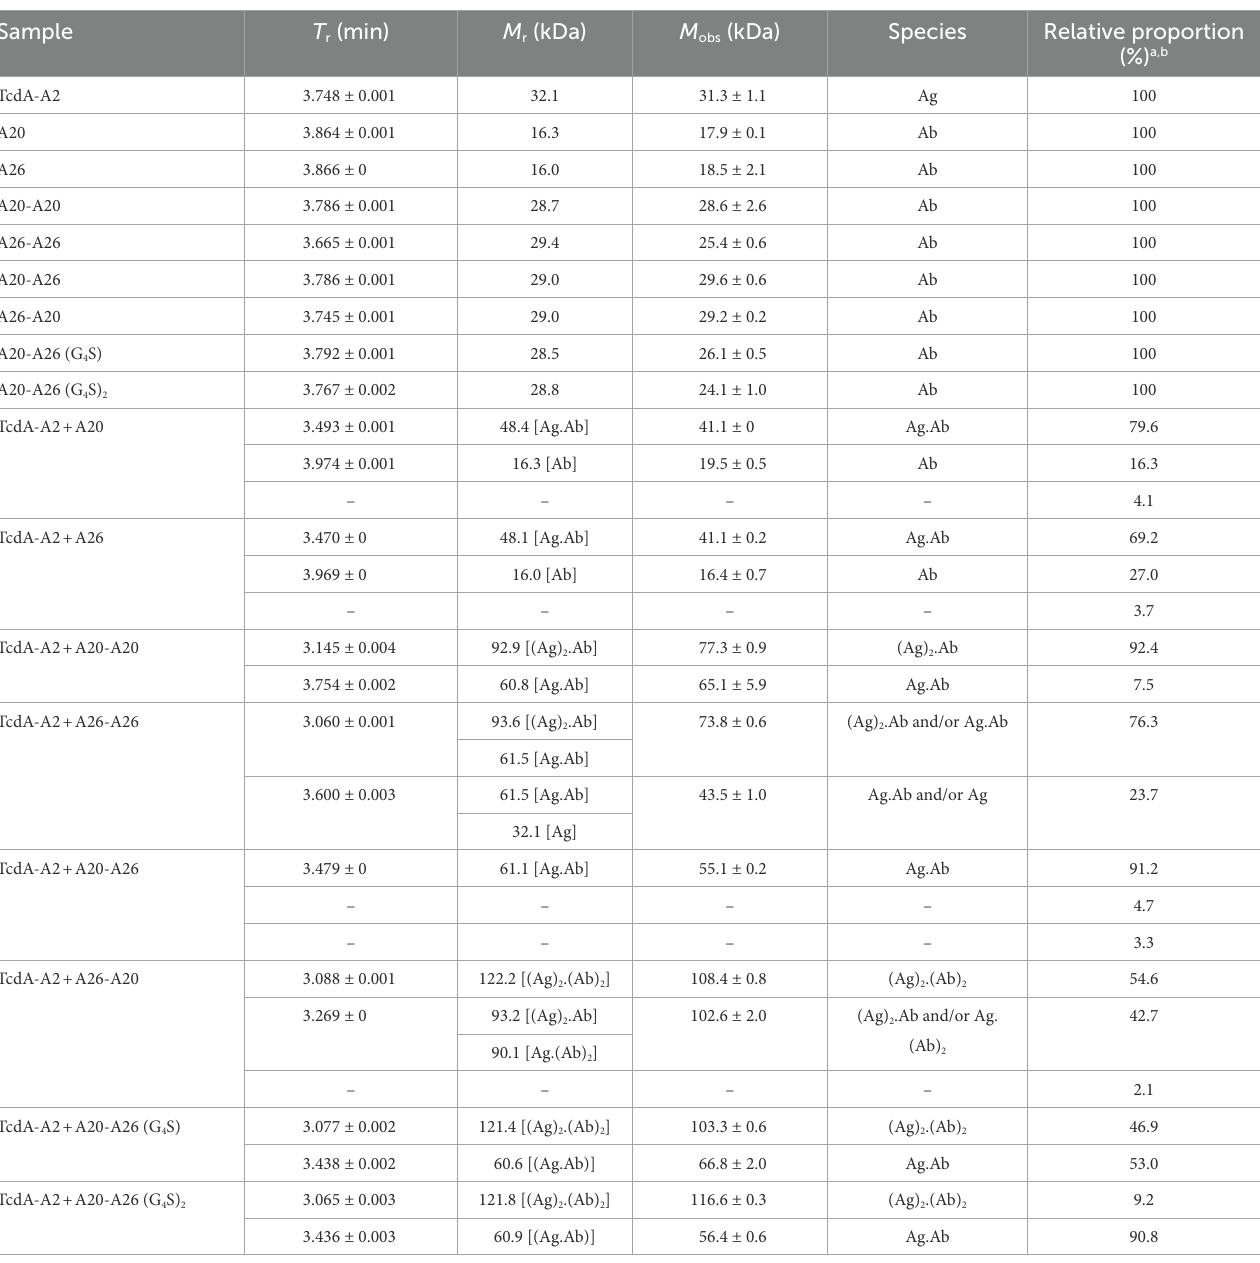
TABLE 3 SEC-MALS derived molecular masses for TcdA-A2 + V H H complexes. Sample